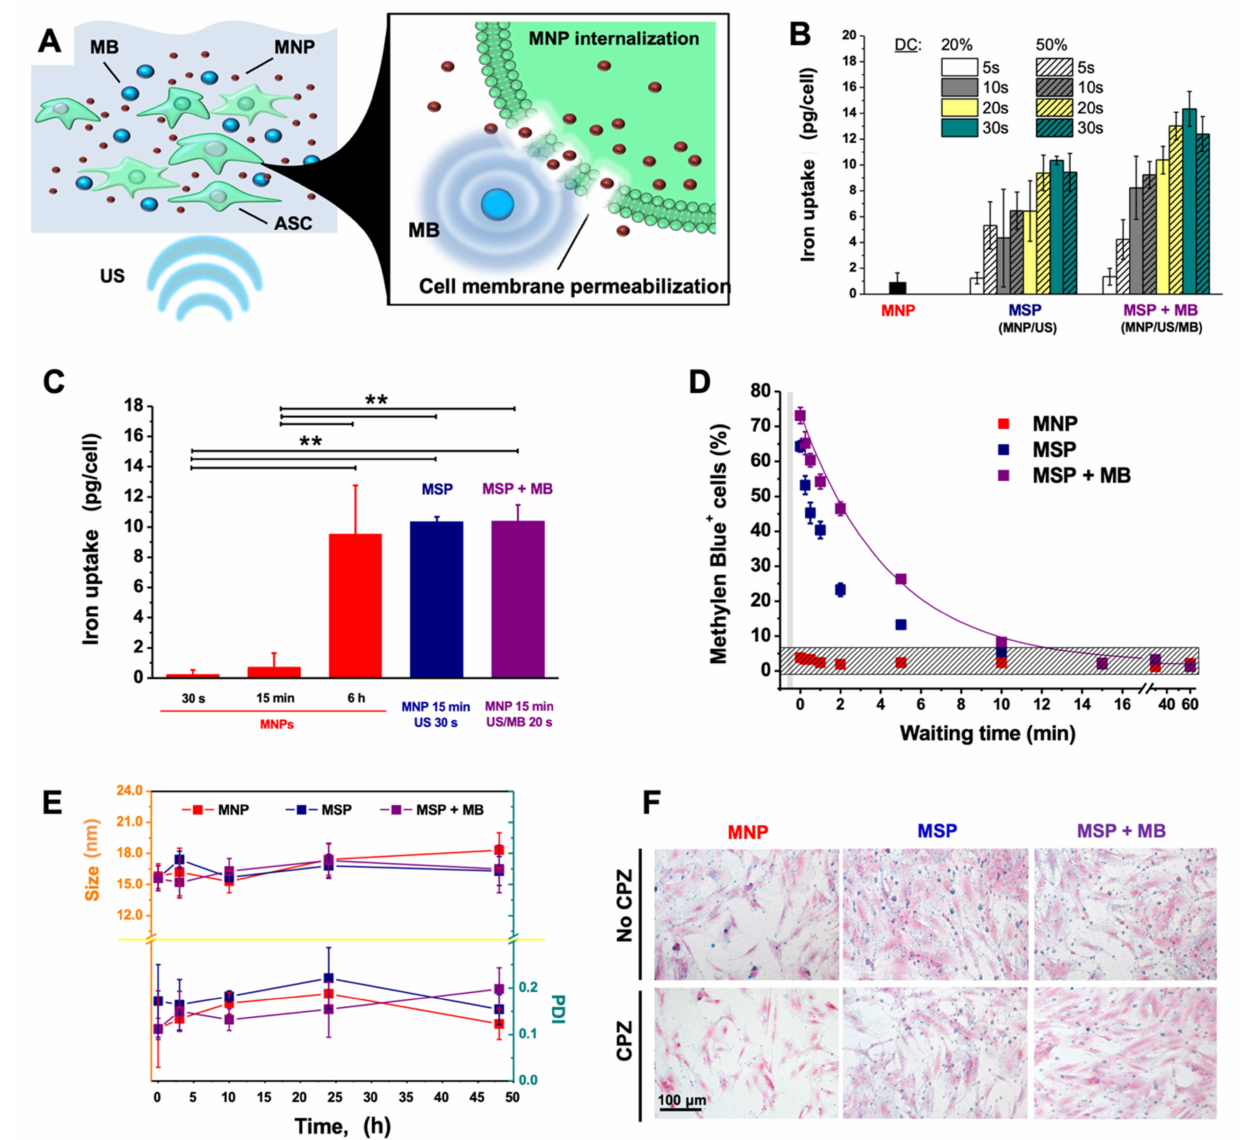
Figure 1. Iron uptake in sonoporated cells. ( A ) Diagram of the working principle of magneto-sonoporation (MSP) using ultrasound (US) in combination or not with microbubbles (MBs) to increase cell membrane permeability. ( B ) To optimize the sonoporation procedure, the cells underwent sonication with different duty cycles for different time ranges at 1.0 W/cm 2 . Other power intensities were also tested (data not shown). ( C ) The magnetic nanoparticles (MNP) uptake was compared among cells undergoing simple incubation for different time ranges (30 s, 15 min, 6 h), or upon sonication in the presence or absence of MBs (MSP and MSP + MB, respectively). ** p < 0:01. ( D ) In order to estimate the resealing time of the cell membrane after sonication, the cells were subjected to the Methylene Blue Permeability assay. Cells positive for the dye were considered to have altered membrane permeability and their fraction over the total population was plotted against time. ( E ) The stability of MNPs in culture media following MSP in the presence or absence of MBs was assessed by monitoring the mean hydrodynamic diameter (size, nm) and polydispersity index (PDI) via dynamic light scattering (DLS) over time, after dilution into cell culture media and maintenance in cell incubation (37 ◦ C, 5% CO 2 and pH 7.4). ( F ) Internalization of MNPs shown by Prussian Blue staining of ASCs after conventional incubation (6 h), MSP or MSP with MBs (15 min) in the presence or absence of the endocytosis-inhibitor chlorpromazine (CPZ). Equivalent volumes of phosphate-buffered saline (PBS) in the culture medium were used as controls